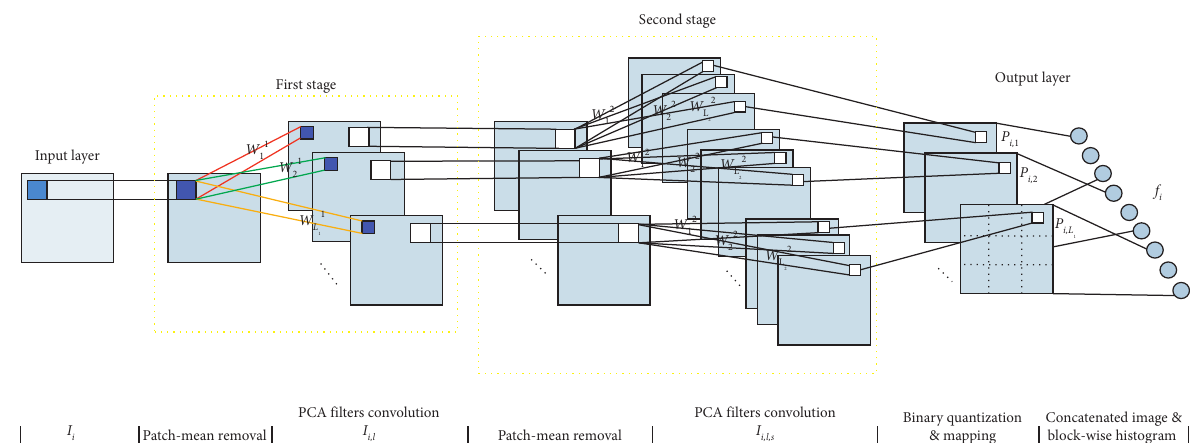
Figure 1: The structure of the PCANet model.